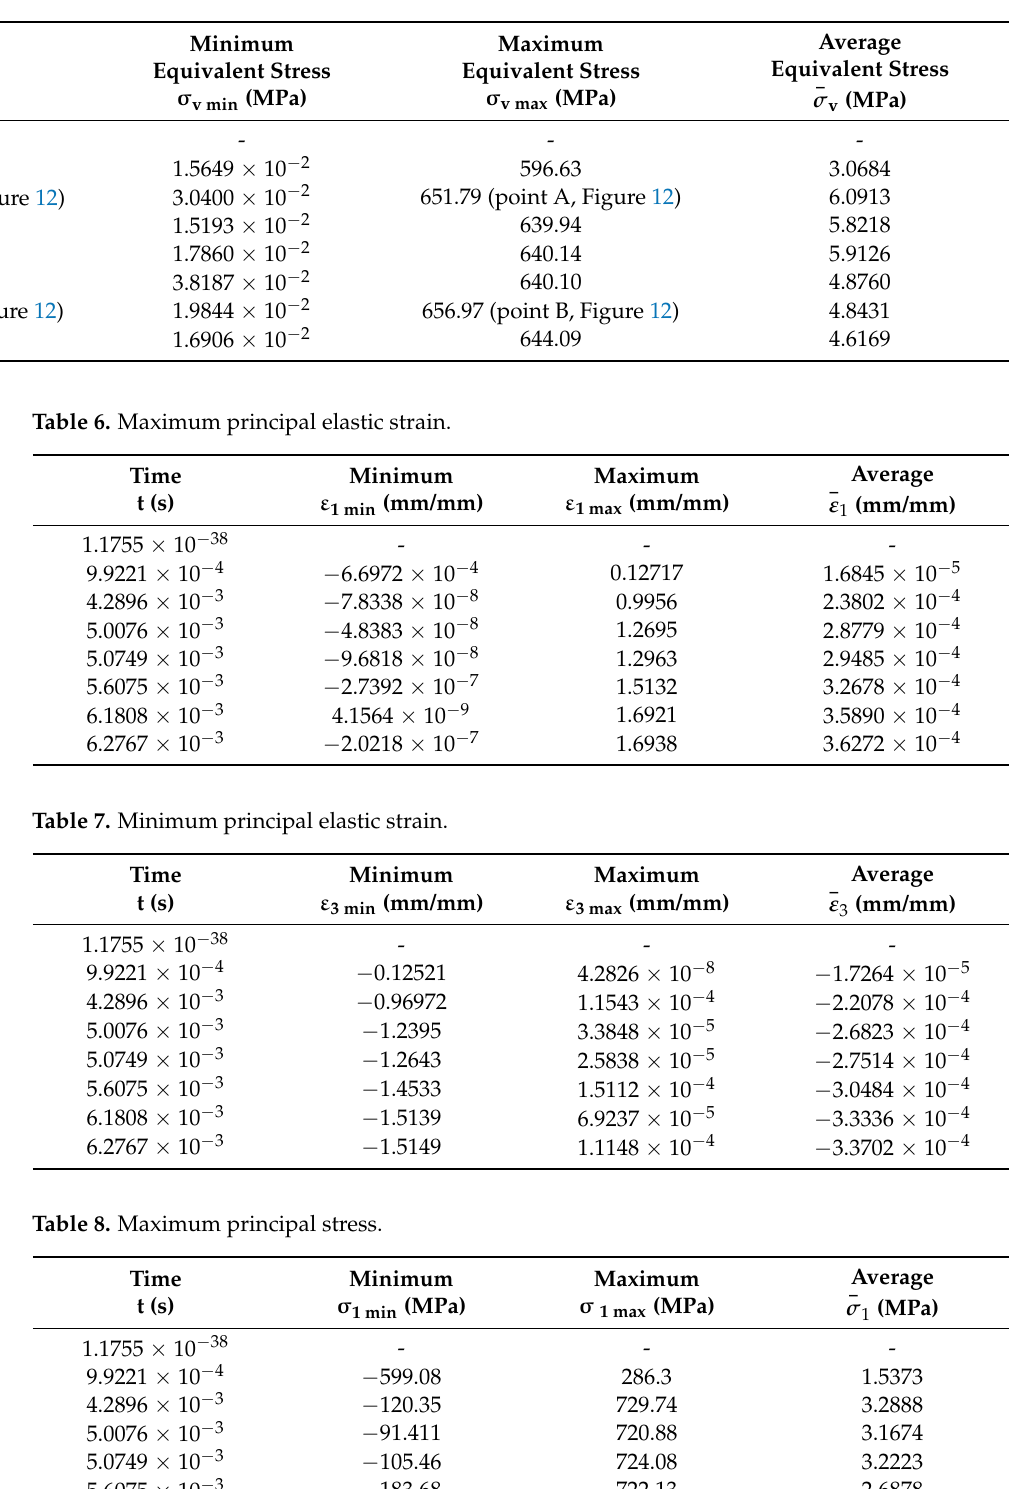
Table 5. Equivalent stress (von Mises).